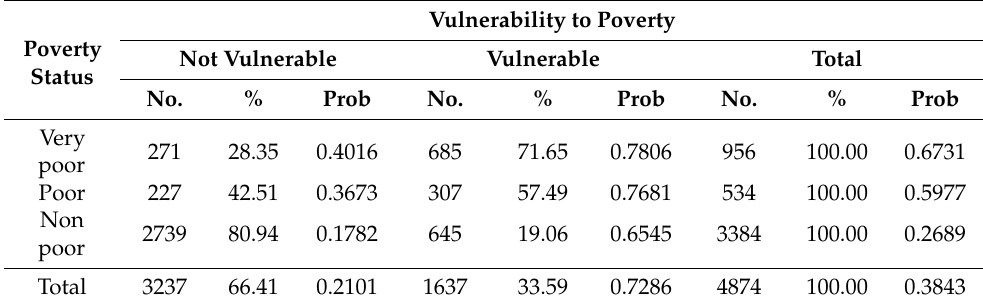
Table 9. Vulnerability without Social Expenditure,